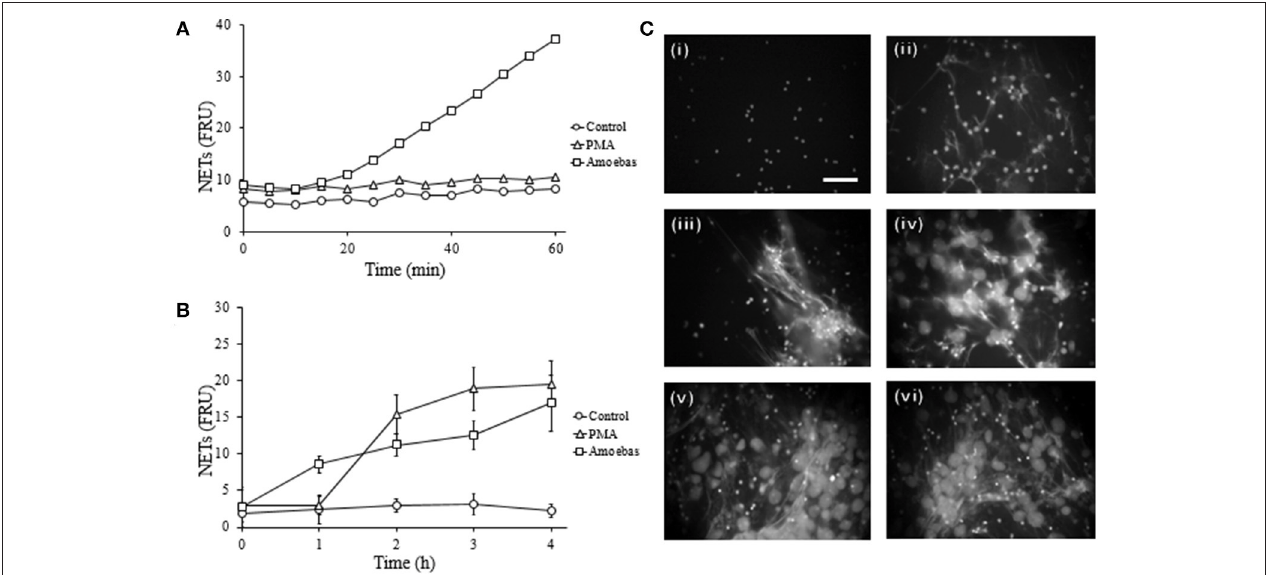
FIGURE 4 | E. histolytica trophozoites induces a rapid NETosis process. (A) Neutrophils (1 × 10 5 ) were co-culture with trophozoites (5 × 10 3 ) in RPMI medium added with 500nM SYTOX Green and fluorescence values were measured every 5min during 1h. (B) Neutrophils (3 × 10 5 ) were co-cultured with trophozoites (1.5 × 10 4 ) in RPMI medium for the indicated times; supernatants were collected, mixed 1:1 with 500nM SYTOX Green and the fluorescence measured. In (A,B) 20nM PMA was used as positive control of NETosis, NETs amount is expressed in fluorescence relative units (FRU) and values are means ± SD of three independent experiments in triplicate. (C) Neutrophils were stimulated with 20nM PMA (4h) or amoebas (ratio 20:1) during 1, 2, 3, and 4h and the cells fixed and stained with DAPI. Control neutrophils (i), neutrophils treated with PMA (ii), neutrophils co-cultured with amoebas for 1h (iii), 2h (iv), 3h (v), and 4h (vi). Images were taken at 60x magnification. Scale bar 50 µ m.